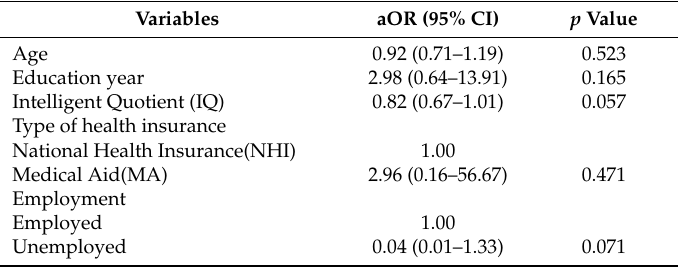
Table 4. Factors associated with psychiatric disorders in unwed